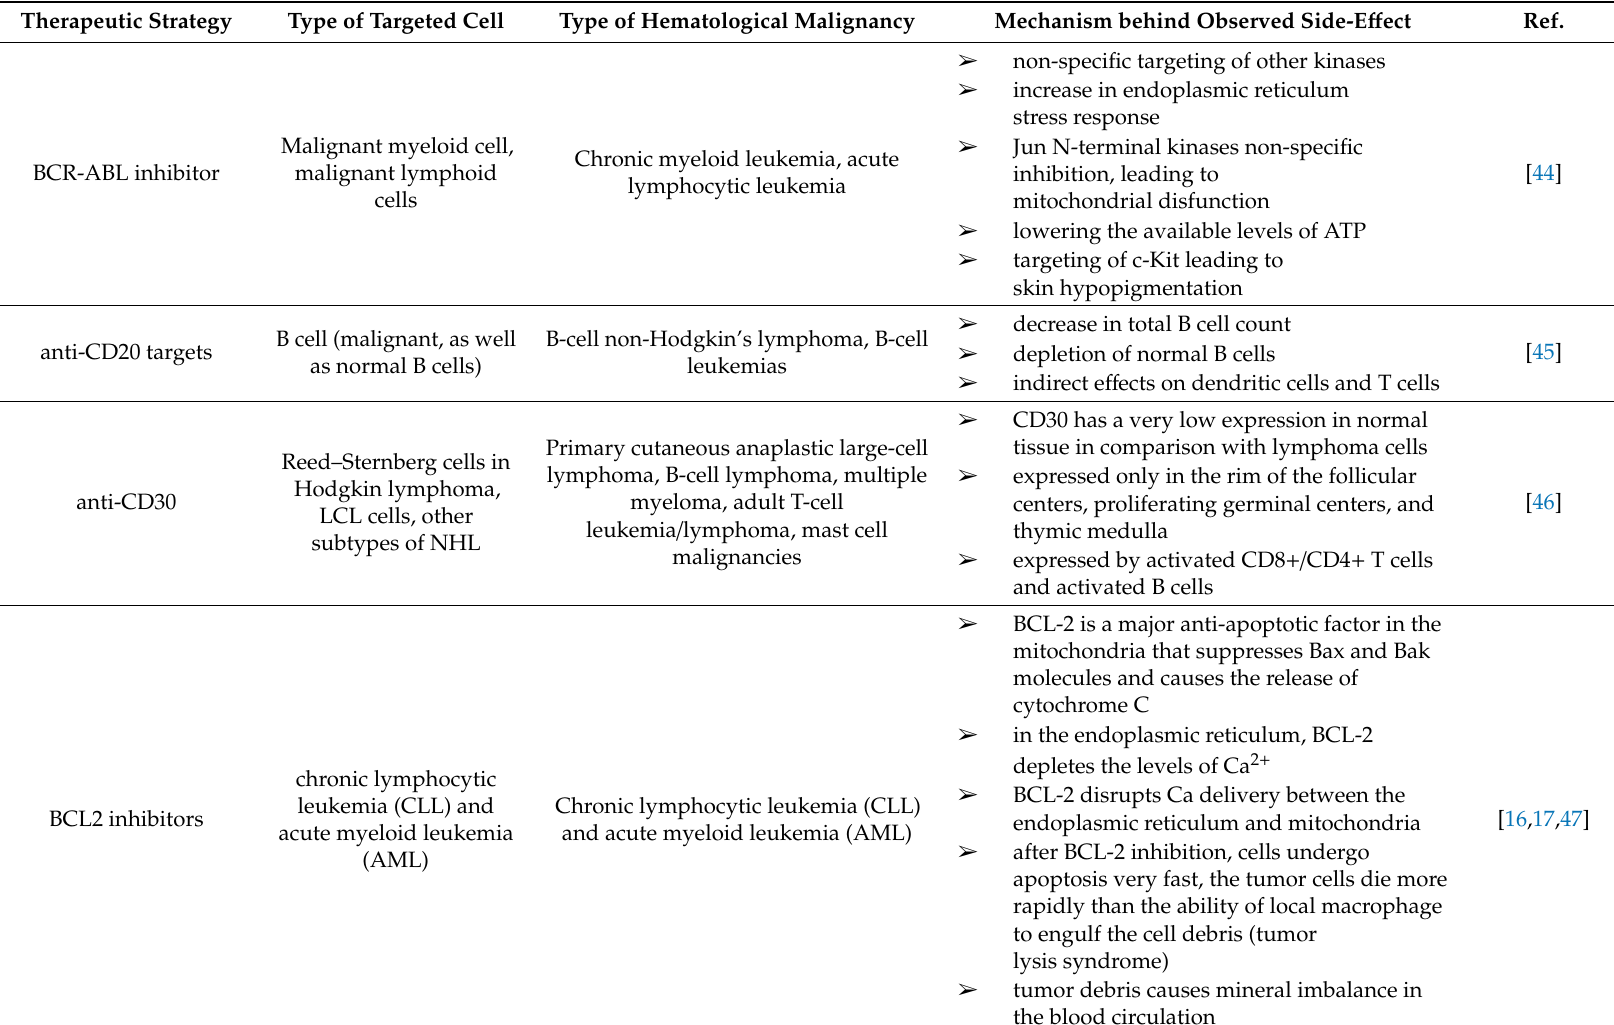
Table 1. Molecular / biological mechanisms behind the observed side-e ff ects of the most common therapeutic strategies applied in hematological